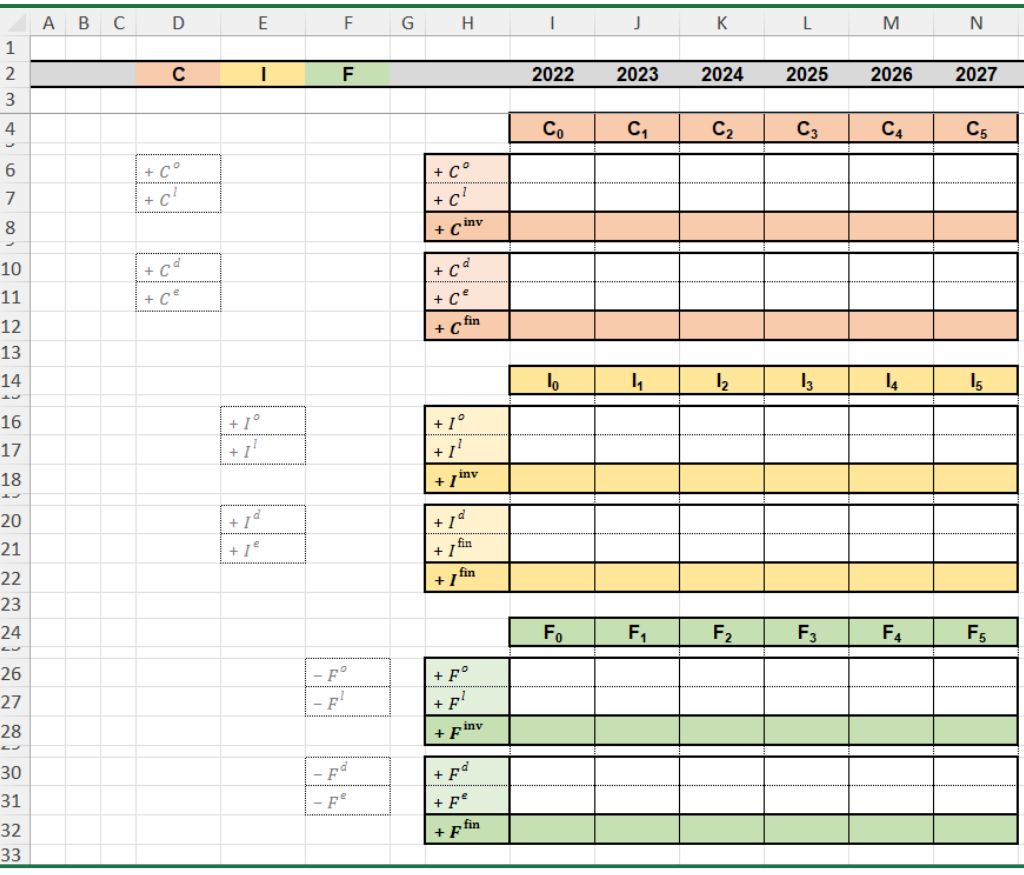
Figure 40. Structure of the Transposed Matrix (“TransMatrix” sheet).